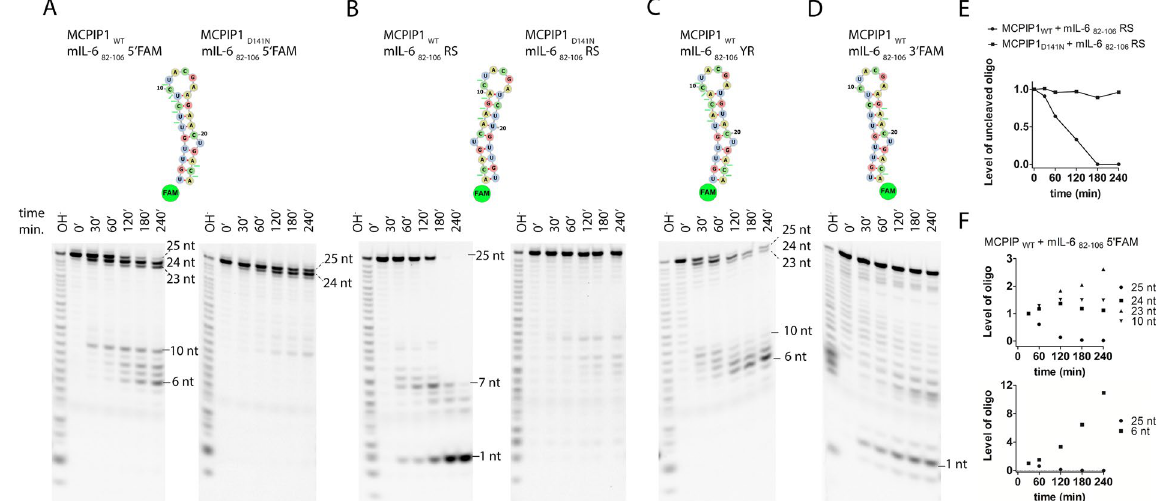
Figure 1. RNA fragments obtained upon MCPIP1-catalyzed cleavage. ( A ) Sequences and structures of the 25-nt-long RNA stem-loops derived from the mIL-6 82–106 3 ′ UTR fragment are depicted. ( B) Degradation assay of the modified mIL-6 82–106 stem-loop (RS – reverse stem alteration). ( C ) Degradation assay of the modified mIL-6 82–106 stem-loop (YR – pyrimidine and purine alterations). ( D) Degradation assay of the mIL-6 82–106 stem-loop labeled at the 3 ′ end. The oligonucleotides were labeled at the 5 ′ or 3 ′ end with FAM dye. The reaction products were resolved on 20% denaturing PAGE and visualized with a fluorescence imaging system. Concentrations of the labeled oligonucleotides and MCPIP1 protein were 7.5 μ M and 2 μ M, respectively. The D141N mutation of a conserved aspartate of the PIN domain catalytic center of the MCPIP1 decreased its ribonucleolytic activity. ( A – D ) Were made by the separation of gels that are shown at Supplementary Fig. S2A,D. Major sites of MCPIP1-induced cleavage are indicated by the oligonucleotide fragment length. ( E ) Densitometric analysis of the kinetics of RNA degradation presented as the level of the remaining uncleaved oligonucleotides from the RNase assay. The graph shows the level of the stem-loop sequence: mIL-6 82–106 RS during degradation. ( F ) Densitometric analysis of the MCPIP1 WT induced degradation of the mIL-6 82–106 5 ′ FAM oligonucleotide. Analysis was carried out separately for each of degradation products of the mIL-6 82–106 5 ′ FAM. Oligonucleotide levels were normalized at the time 30